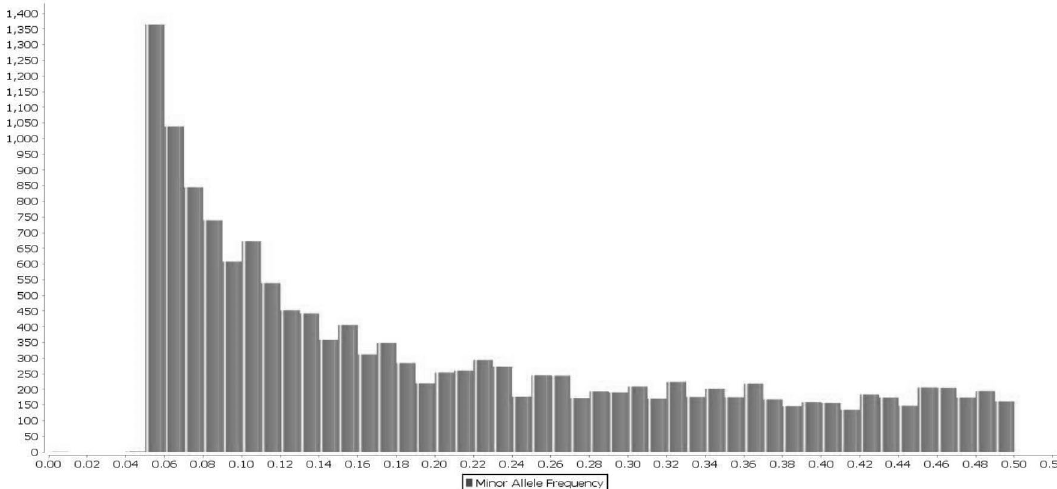
Figure 5. The Minor Allele Frequency distribution of 14,522